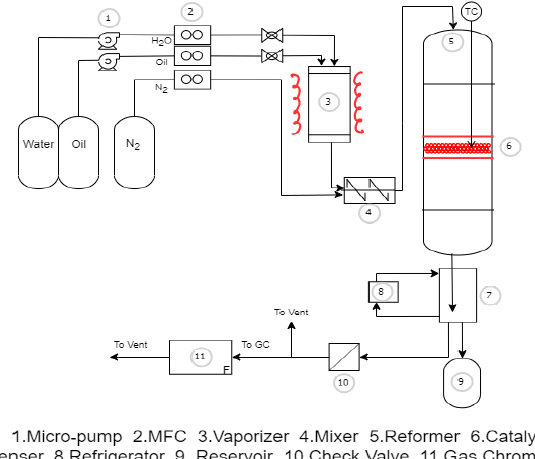
Figure 2. Schematic diagram of the pyrolysis oil reforming reactor.